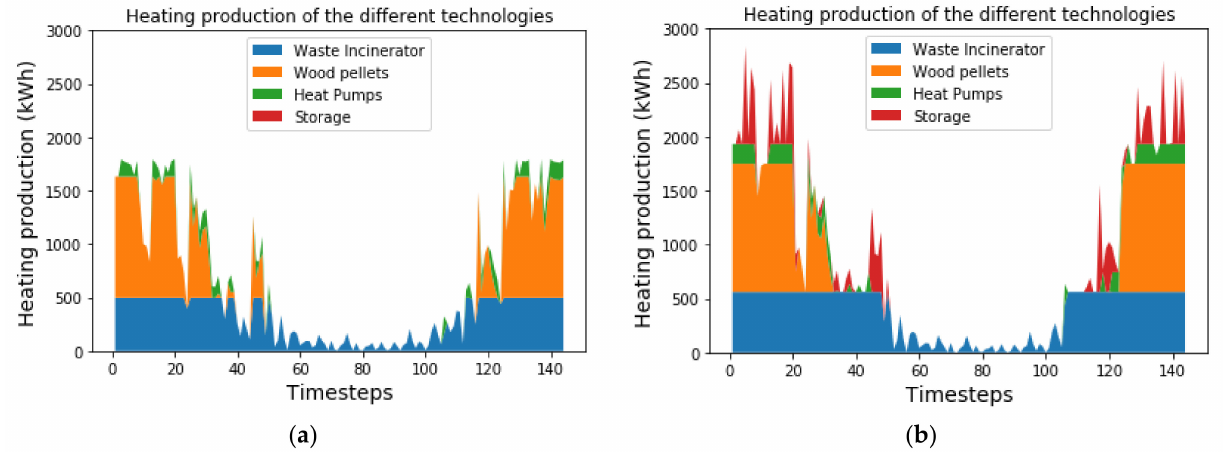
Figure 17. ( a ) Heating production without storage capacity. ( b ) Heating production with storage